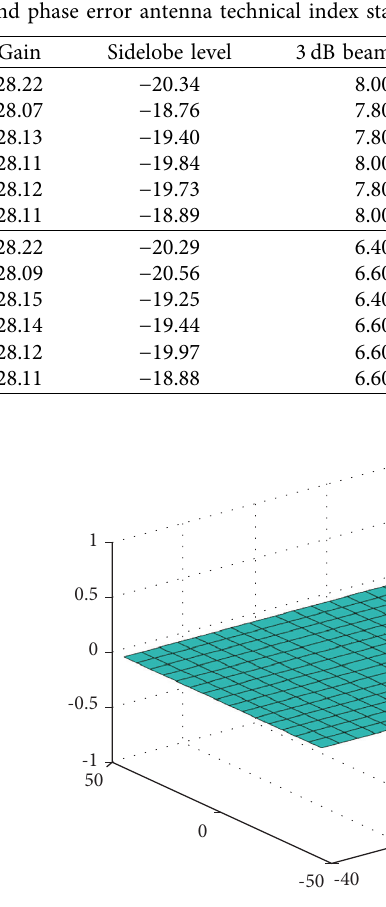
Figure 7: Position error of the left and right half arrays in the X -